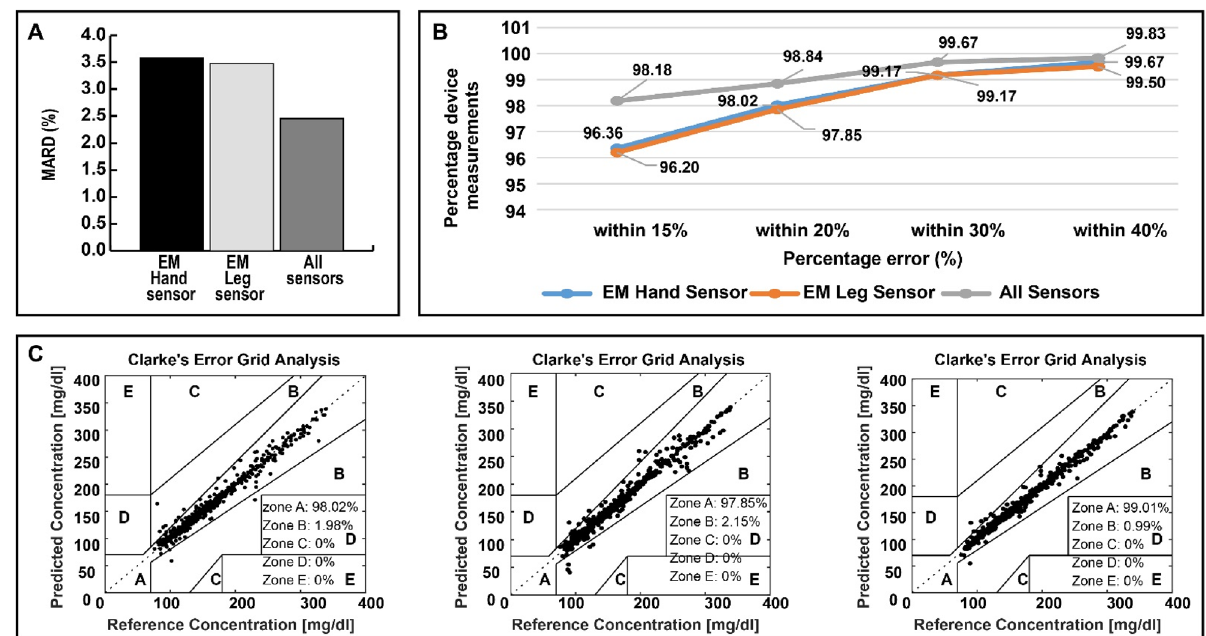
Figure 8. Comparison between the standalone and combined multi-location system. ( A ) MARD for the 28 experiments. ( B ) Percentage of device measurements with 15%, 20%, 30% and 40% error. ( C ) CEG for all the OGTT conducted by the 28 volunteers for the standalone systems and the combined